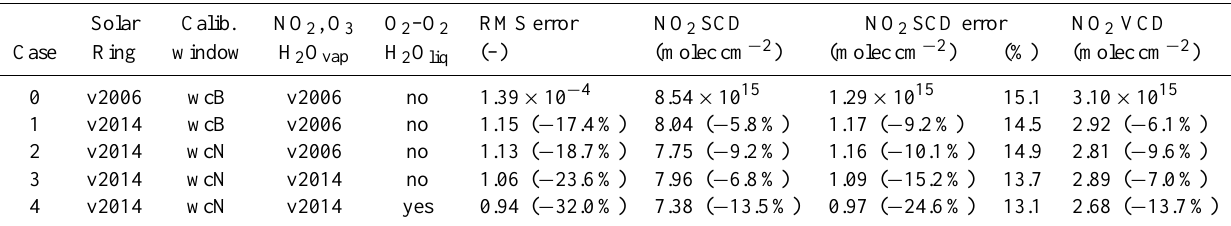
Table 4. Results of the NO 2 SCD fit for the different steps of the updates of the OMNO2A processing for the Pacific Ocean orbit. Case 0 represents the current OMNO2A version (v1) and case 4 is the updated version (v2) settings. Cases 1 through 4 follow the updates listed at the beginning of Sect. 5. The numbers between parentheses are percentage changes w.r.t. case 0. The NO 2 SCD error is given in absolute value and as percentage of the NO 2 SCD column. The NO 2 VCD in the last column is determined from the SCD and the geometric air-mass factor.